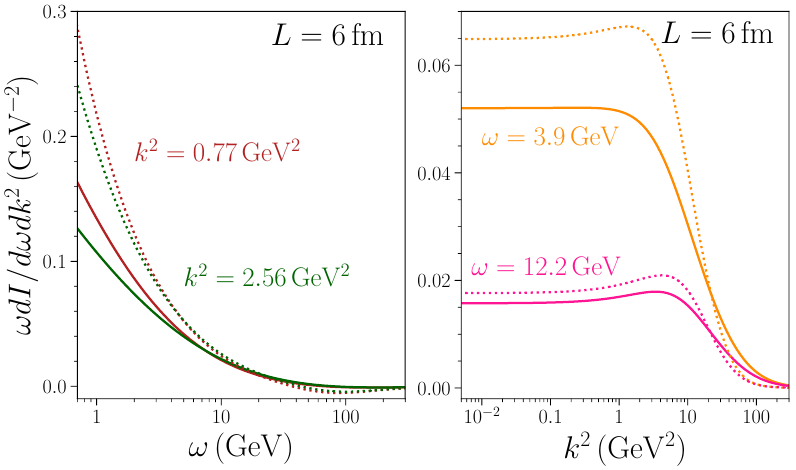
Figure 5 . Full medium-induced gluon k ? -di(cid:11)erential spectrum for the Yukawa collision rate with (cid:22) = 1 : 6 GeV for a medium of L = 6 fm and n 0 L = 5 (solid lines) compared to the evaluation in the harmonic approximation (dotted lines) with ^ q = 2 : 8 GeV 2 = fm. The left panel shows these two evaluations as function of the emitted gluon energy ! for two di(cid:11)erent values of the gluon transverse momenta k . The right panel shows these spectra versus k 2 for two di(cid:11)erent values of ! . The results for the k -di(cid:11)erential in-medium spectrum for the full resummed solution ? (solid) and the HO approximation (dash-dotted) are shown in (cid:12)gure 5 with (cid:22) = 1 : 6 GeV (or (cid:22) ! = 39 GeV) for the full result and ^ q = 2 : 8 GeV 2 = fm (or ! (cid:17) ^ qL 2 = 2 = 256 c c